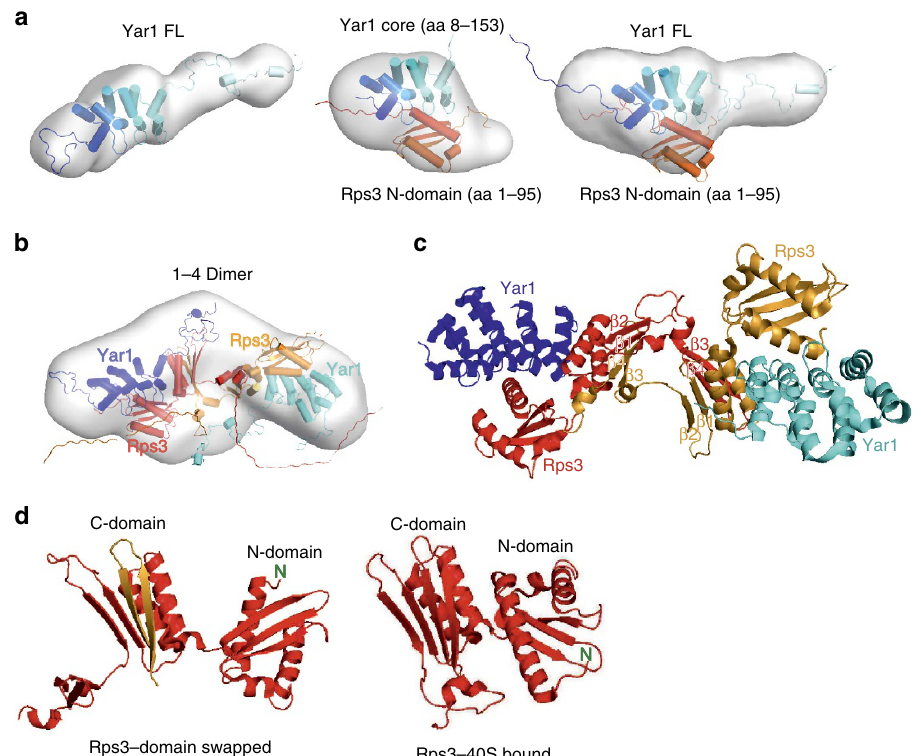
Figure 1 | The Rps3 C-domain is rotated relative to the N-domain and dimerizes by domain swapping. ( a ) Model fit into a representative SAXS envelope for full-length Yar1 (FL), Rps3 N-domain (1–95)/Yar1 core (8–153) complex, Rps3 N-domain/Yar1-FL complex. Yar1 is coloured from blue (N terminus) to light blue (C terminus), Rps3 is coloured in orange. ( b ) Tetrameric arrangement of full-length Rps3/Yar1 complex. A representative envelope and the best fitting model of the dimeric conformations shown in Supplementary Fig. 2c extracted from the crystal structure (1–4 dimer) are shown. ( c ) Crystal structure of the 1–4 dimer (Protein Data Bank (PDB) 4BSZ). The same colours are used as in ( b ). The four b -sheets of the Rps3 C-domain were numbered to highlight that b -sheets 3 and 4 are swapped between the two Rps3 molecules. ( d ) Rps3 structure extracted from ( c ) with completion of the fold by the two swapped b -sheets (left panel). Domain swapping restores a similar fold of the C-domain as found in ribosome-bound Rps3 (PDB 3U5C, right panel). Comparing the two Rps3 conformations, the N-domain is rotated by B 180 (cid:2) relative to the